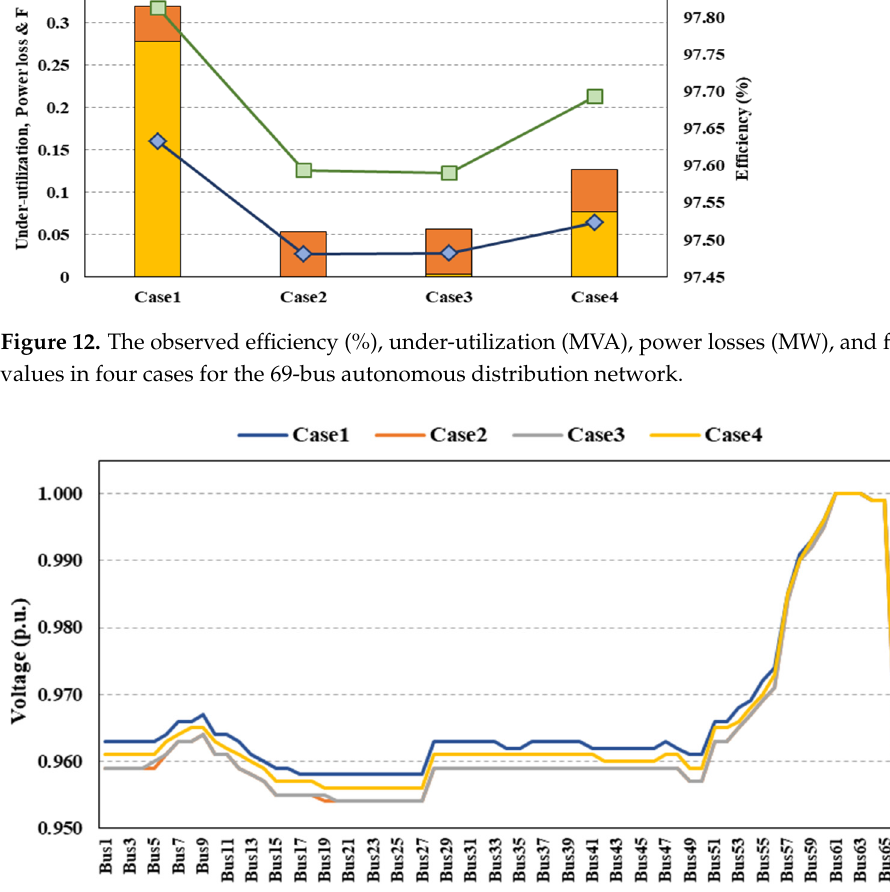
Figure 13. Voltage profiles of autonomous 69-bus distribution network.